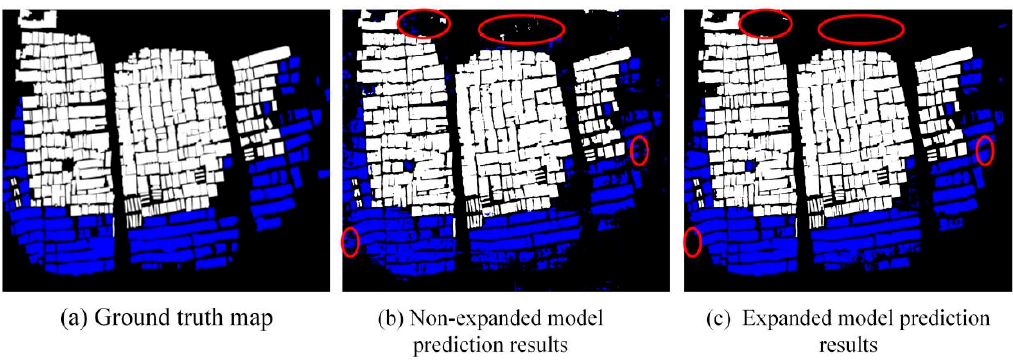
Figure 11. ( a ) The ground truth map; ( b ) the prediction result of non-expanded model; ( c ) the prediction result of expanded model (black is the background, white is fish row cage aquaculture, and blue is floating raft aquaculture).